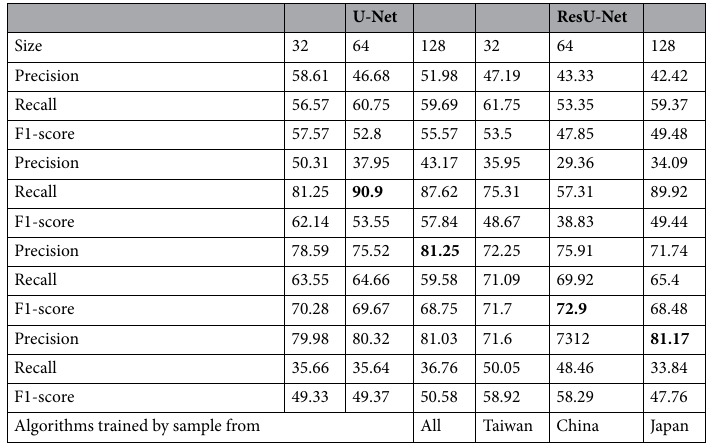
Table 6. The resulting precision, recall, and f1-score values for Scenario 3 (training the algorithms with the training dataset of China and testing on the Taiwan, China, Japan, and all test datasets separately). The highest values of precision, recall, and f1-score are indicated in